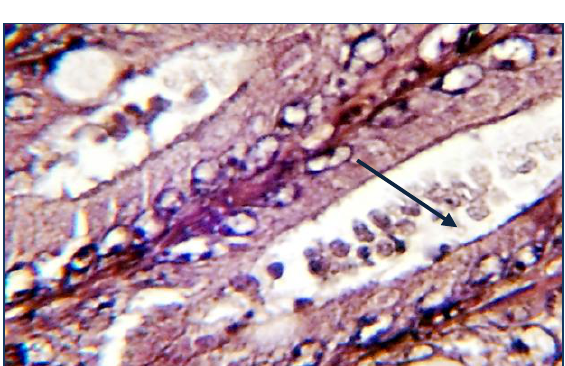
Fig, 1: Histopathological section in the lung of cat shows RBCs, neutrophils in alevolar lumina with accumilation of neutrophils around endospor (H & E stain 40X).